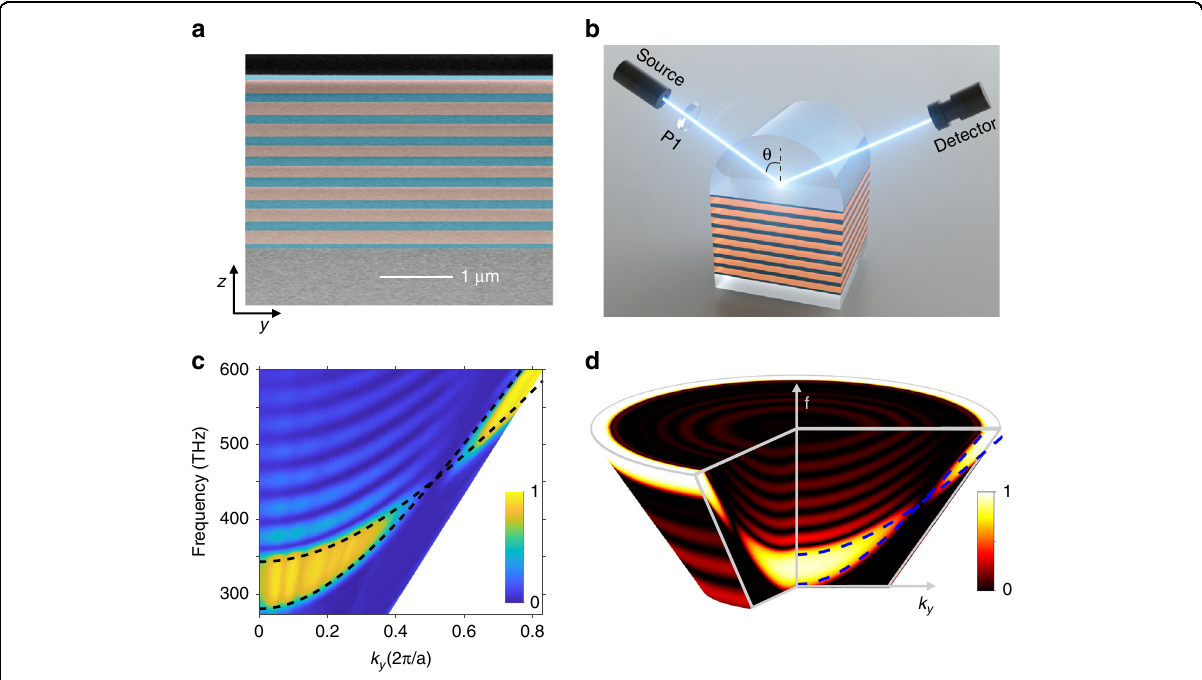
Fig. 3 Experimental demonstration of the type-II nodal ring. a Scanning-electron-microscope (SEM) image of the fabricated sample. b Experimental setup for measuring the angle-resolved re fl ection spectra. The sample is contacted to a half cylindrical prism. P1, polarizer. c , d Measured ( c ) and calculated ( d ) angle-resolved re fl ection spectra for p-polarized incident light. The dashed curves represent the gap edges of the